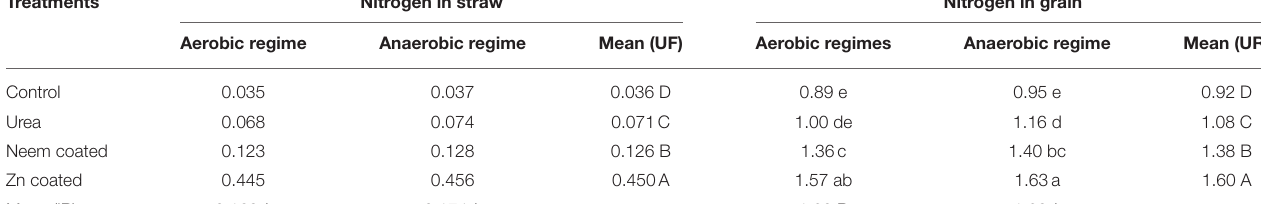
TABLE 4 | Impact of conventional urea, neem-coated urea, and zinc-coated urea on the concentration of nitrogen in straw and grains, protein contents in grain, and grain water absorption ratio of rice plants grown in aerobic and anaerobic regimes. Treatments Nitrogen in straw Nitrogen in grain Aerobic regime